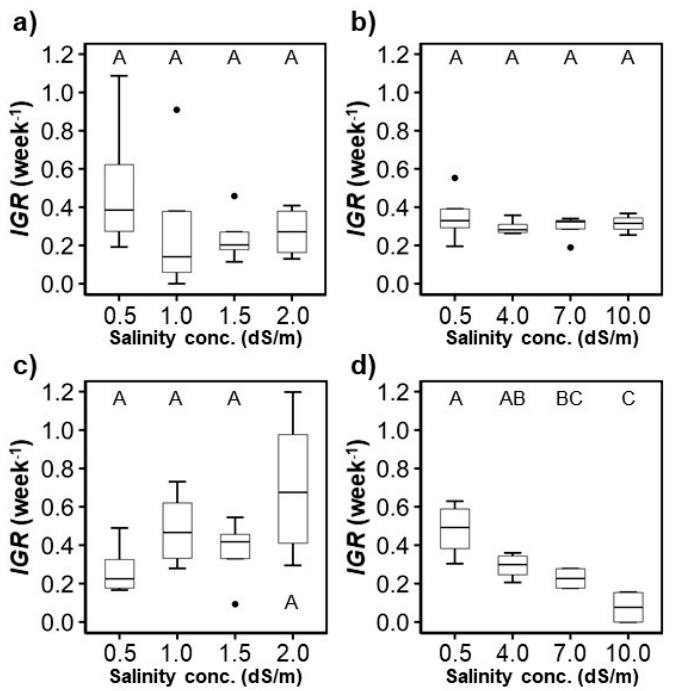
Figure 6. Variation of the intrinsic growth rate (IGR) provided by the fitted logistic growth models: ( a , b ) H. rosa-sinensis ; ( c , d ) M. splendens ; ( a , c ) first experiment; ( b , d ) second experiment. The same upper-case letters in a figure indicate they are not significantly different at the p < 0.05 level by Tukey’s HSD test.